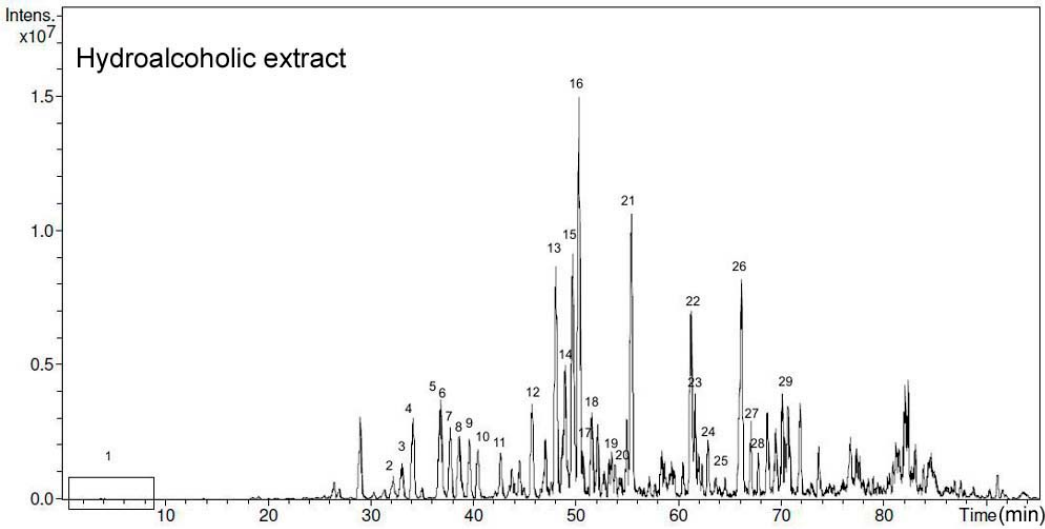
Figure 2. HPLC-MS chromatogram of the various propolis preparations. Polyphenols species are numbered accordingly and listed in Table 1.